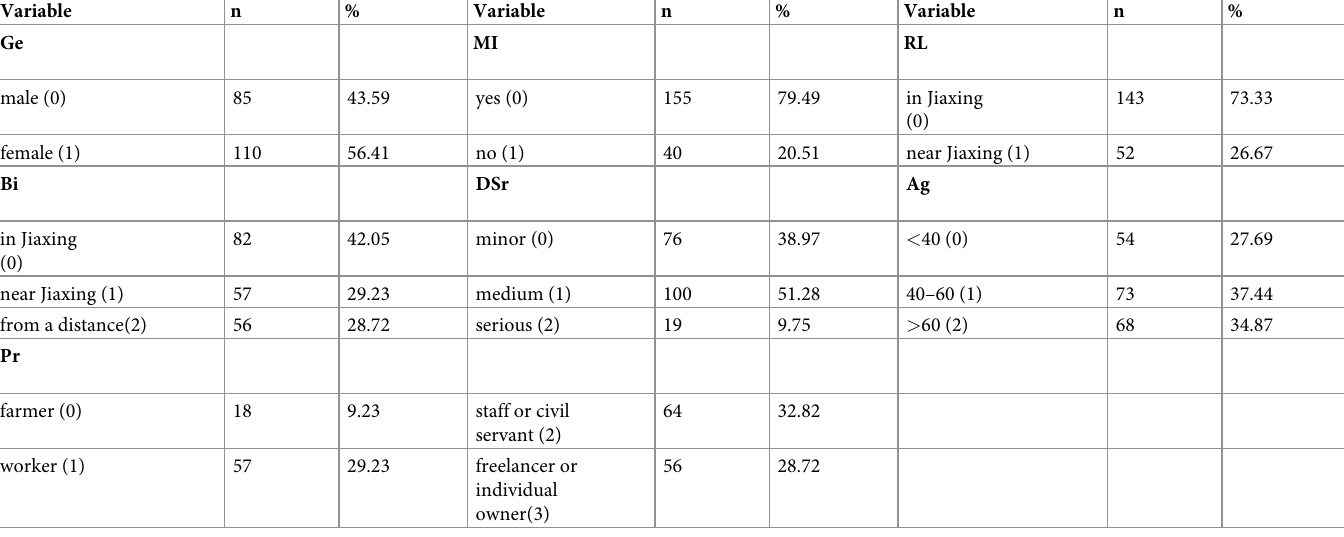
Table 1. Seven outpatients characteristics (N =